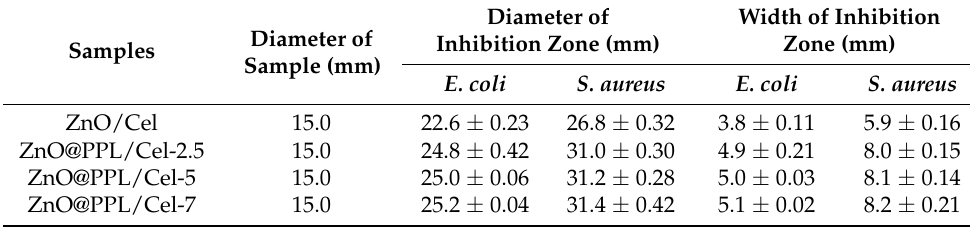
Figure 8. Antibacterial activity of ZnO/Cel and ZnO@PPL/Cel. Table 1. Inhibition zones of ZnO/Cel and